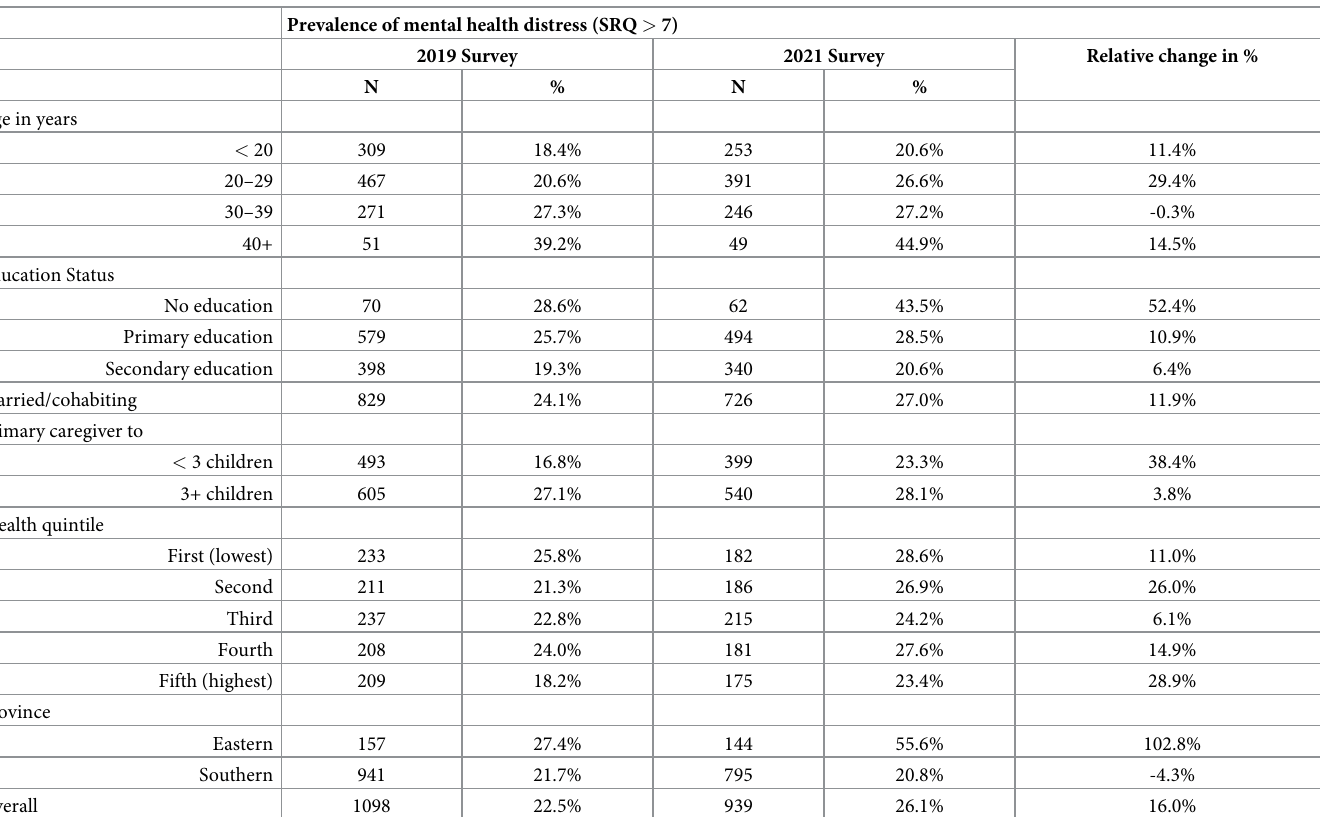
Table 1. Mental health distress by subgroup and survey round (n = 1098).